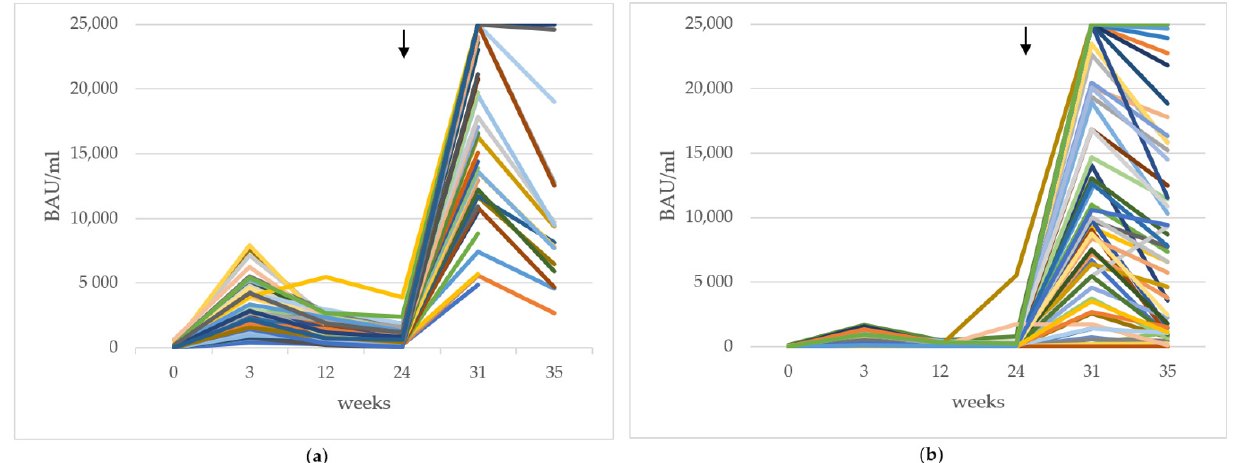
Figure 2. Antibody titres in ( a ) healthy controls, ( b ) all haemodialysis (HD) patients (responders and low/non-responders combined) over the course 35 weeks after administration of the second vaccine dose. Each colored line represents the longitudinal antibody titers of one individual. Booster vaccine doses were applied in October 2021 (week 24 in the figure, denoted with an arrow ↓ ). All values in binding antibody units per milliliter.